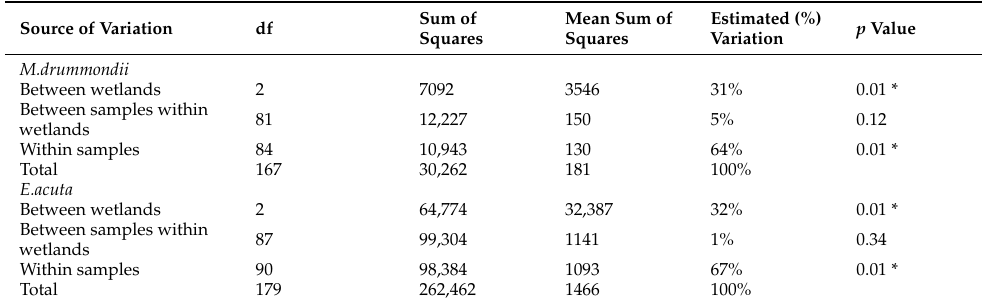
Table 4. Analysis of molecular variance (AMOVA) for M. drummondii and E. acuta . * = significant with p < 0.05.